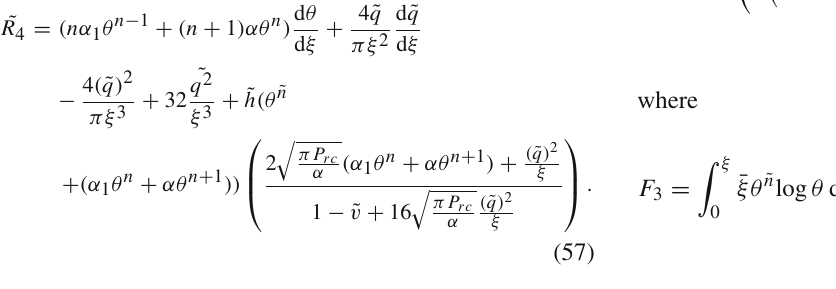
Fig. 6 Case 1: Perturbation through n , h , q . δ R 3 δ n = 1 , α = 0 . 4 , α 1 = 0 . 9 , h = 0 . 5, red curve q = 0 . 2 M (cid:7) , blue curve q = 0 . 4 M (cid:7) , greencurve q = 0 . 6 M (cid:7) , magentacurve q = 0 . 64 M (cid:7)